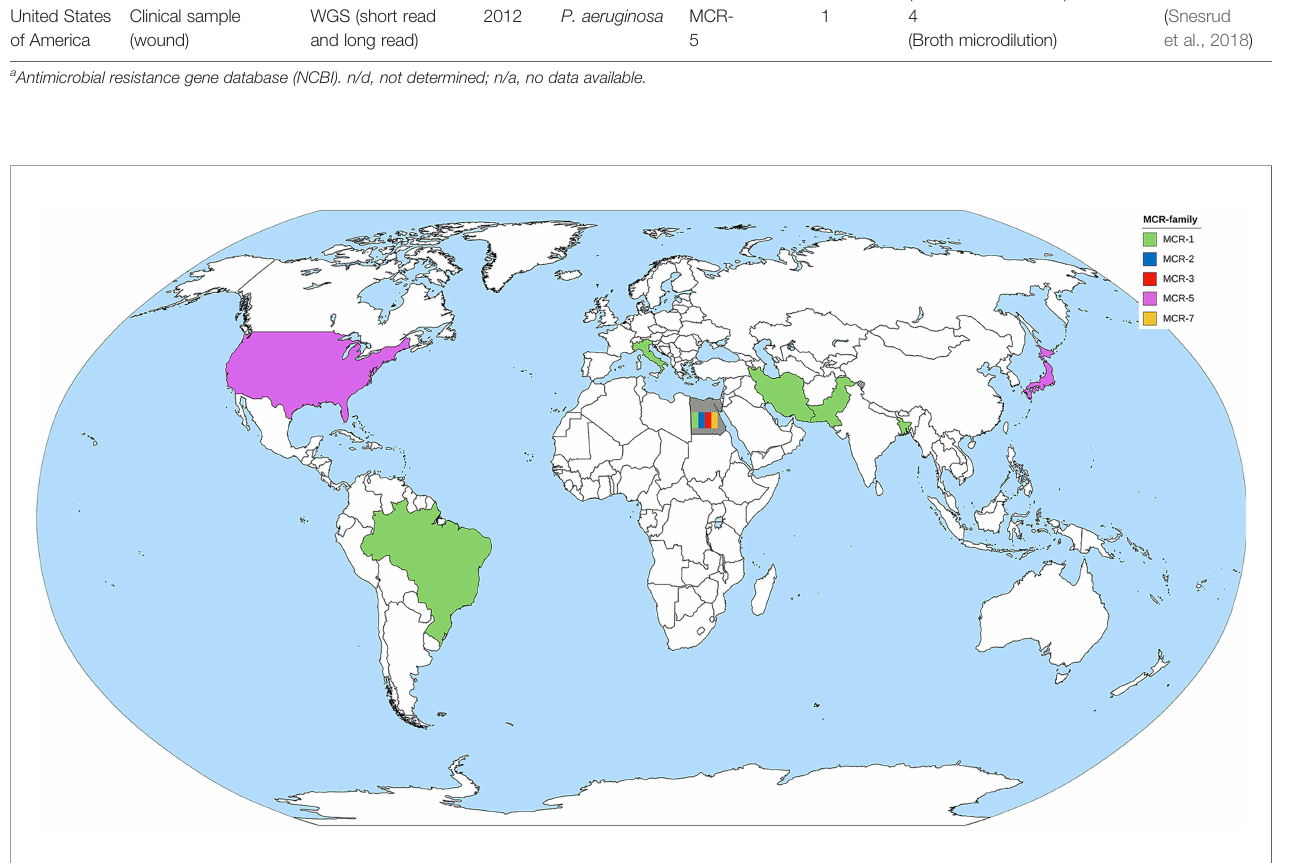
FIGURE 3 | The worldwide dissemination of the mcr gene in Pseudomonas spp. Countries that reported only one type of mcr gene were colored to represent the mcr gene. The country that reported more than one type of mcr gene was fi lled with gray background containing color bands of the reported mcr